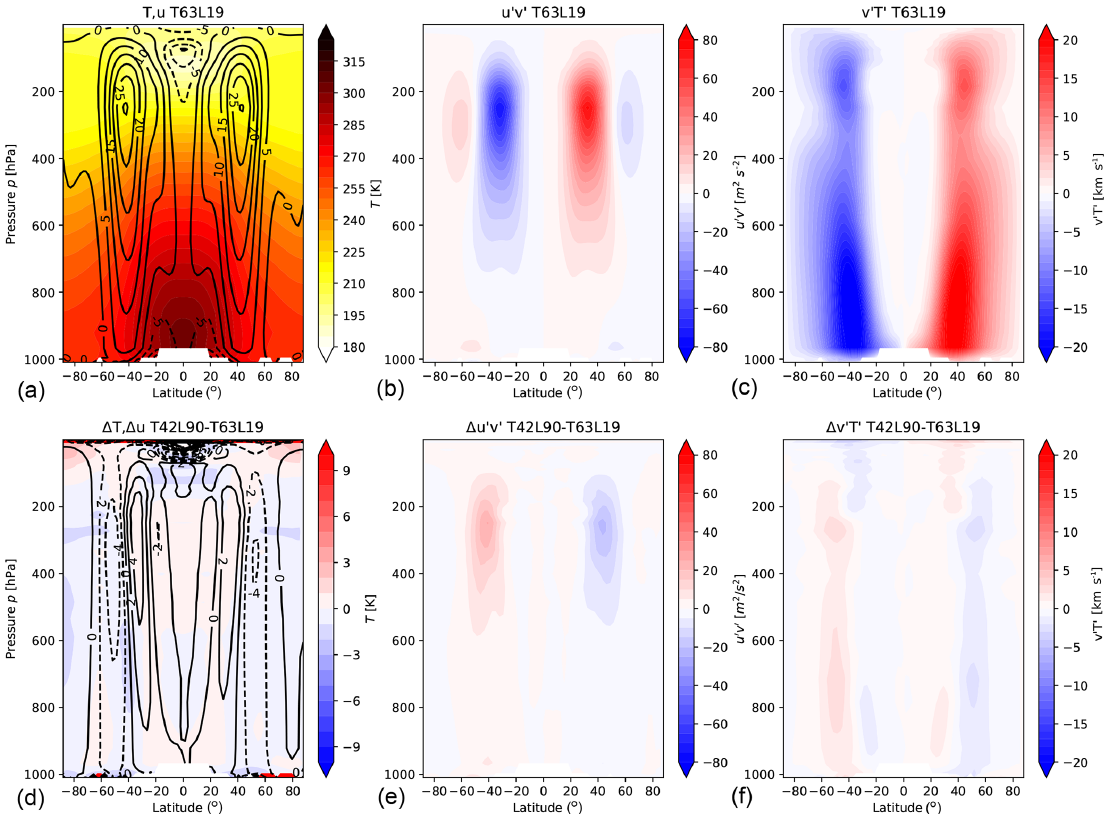
Figure 3. (a, b, c) Results from a HS simulation at T63L19 resolution, showing mean temperature (K) and zonal-mean zonal wind (ms − 1 ; contour interval is 5ms − 1 ) (a, d) , mean eddy momentum fluxes (m 2 s − 2 ) (b, e) and mean eddy heat fluxes (Kms − 1 ) (c, f) averaged over 1500d (after spin-up of 325d). (d, e, f) As above but difference of a simulation at T42L90MA resolution minus the T63L19 simulation (with a wind contour interval of 2ms − 1